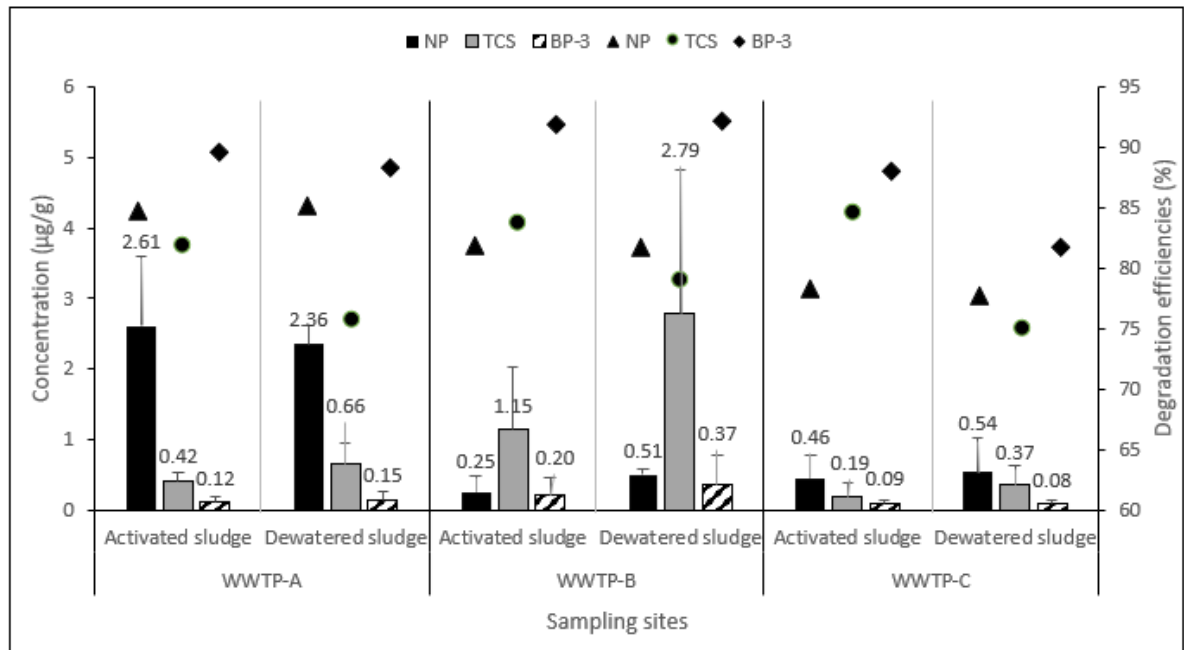
Figure 3. Comparison of three compound concentrations and degradation efficiencies (NP: nonylphenol; TCS: triclosan; BP-3: benzophenone-3) after treatment with PAO in three WWTPs. Concentration of compounds (error bars represent standard deviation of the mean value, n = 6); ▲ degradation efficiencies of NP; ● degradation efficiencies of TCS; ◆ degradation efficiencies of BP- 3.